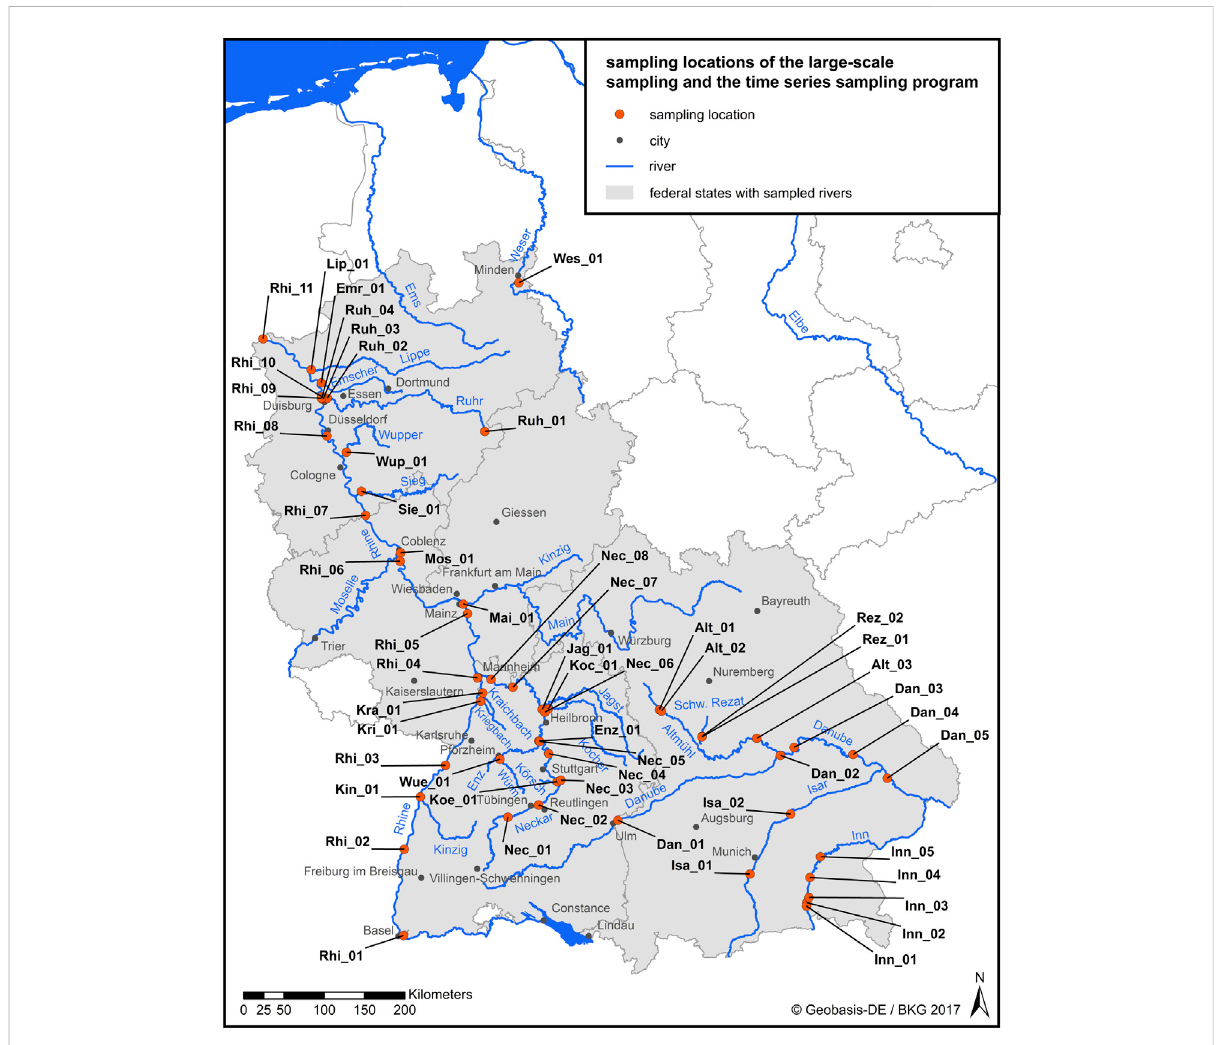
FIGURE 1 Large-scale MP survey at 53 sample locations of 23 rivers in fi ve federal states in the southwestern part of